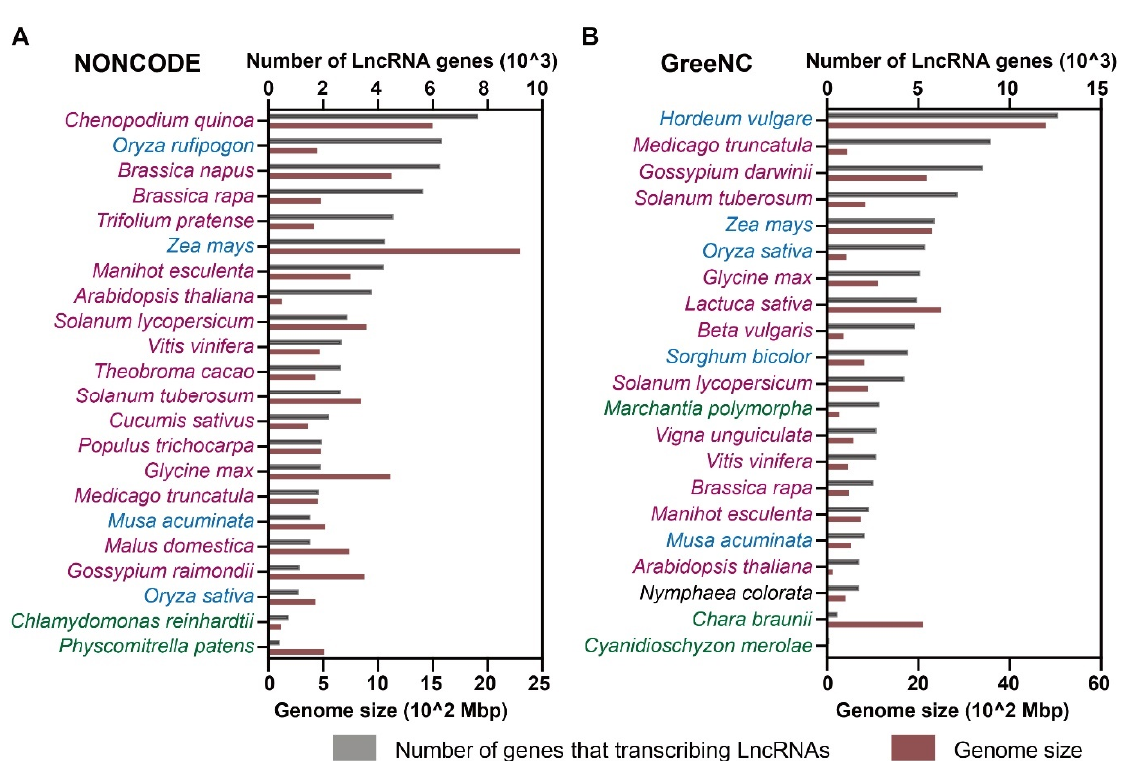
Table 1. Statistics of lncRNAs in plant databases.